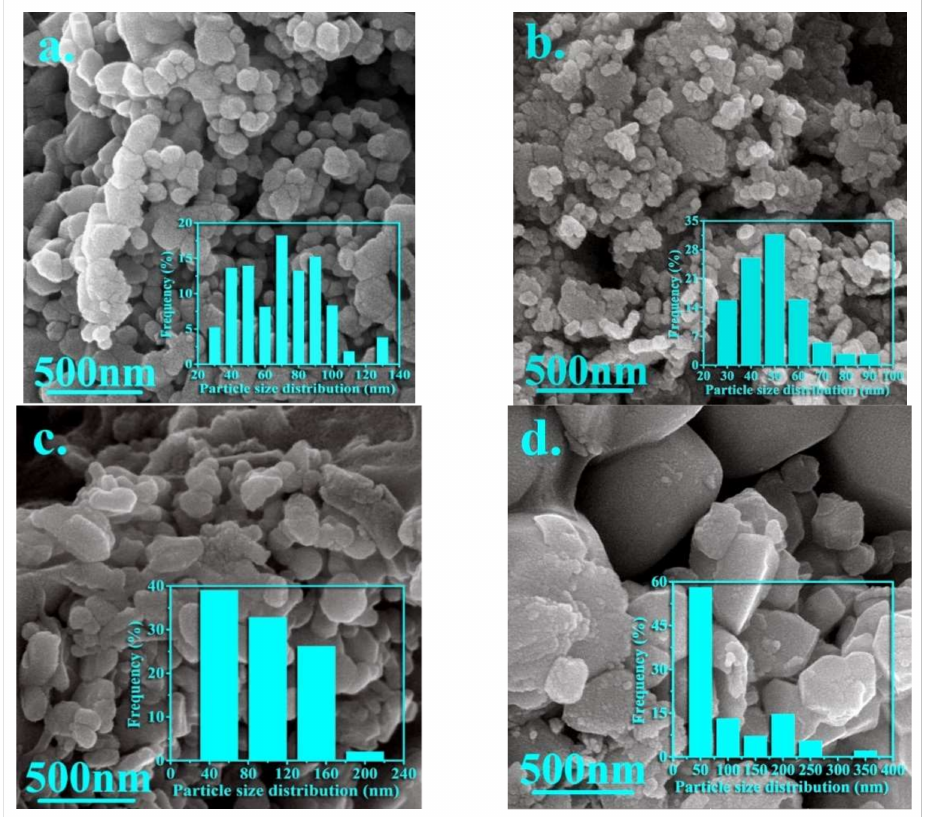
Figure 4. FE-SEM images of the nanoparticles synthesized in the samples ( a ) A, ( b ) B, ( c ) J, and ( d )